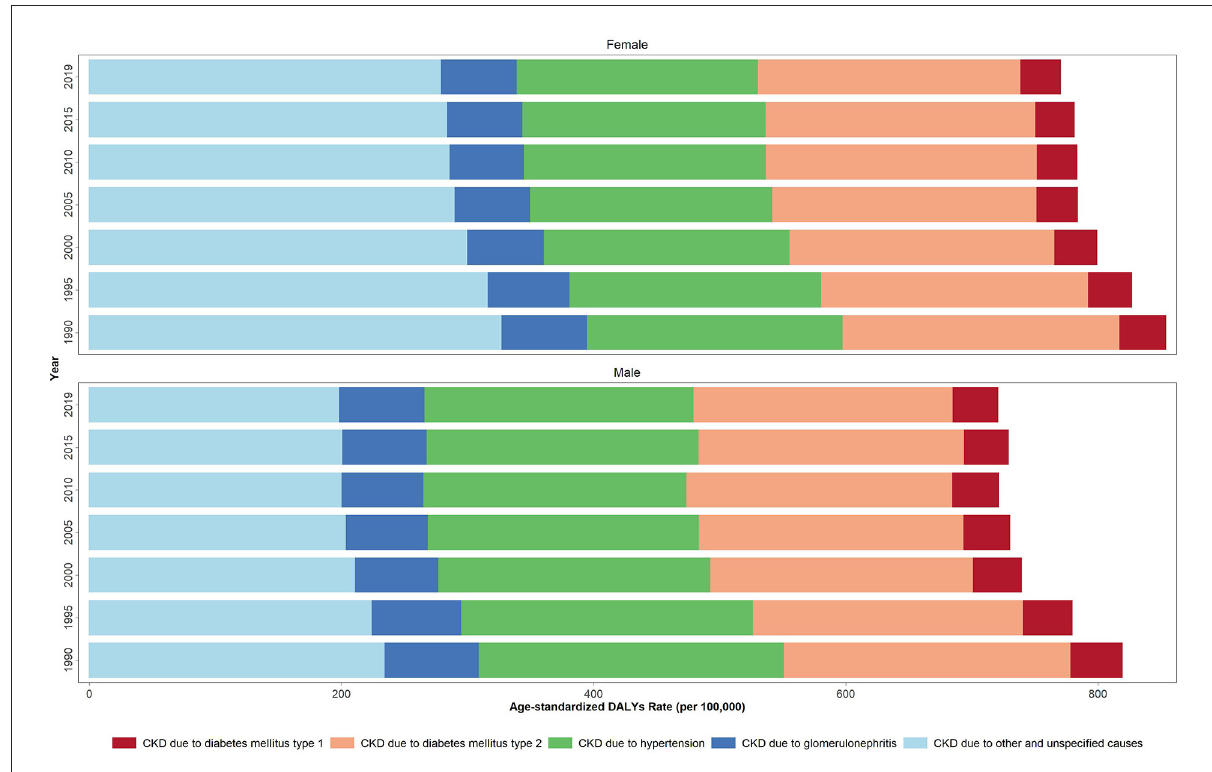
FIGURE1 Age-standardized DALYs rate due to CKD by underlying causes in 1990, 1995, 2000, 2005, 2010 and 2019 in the NAME region.